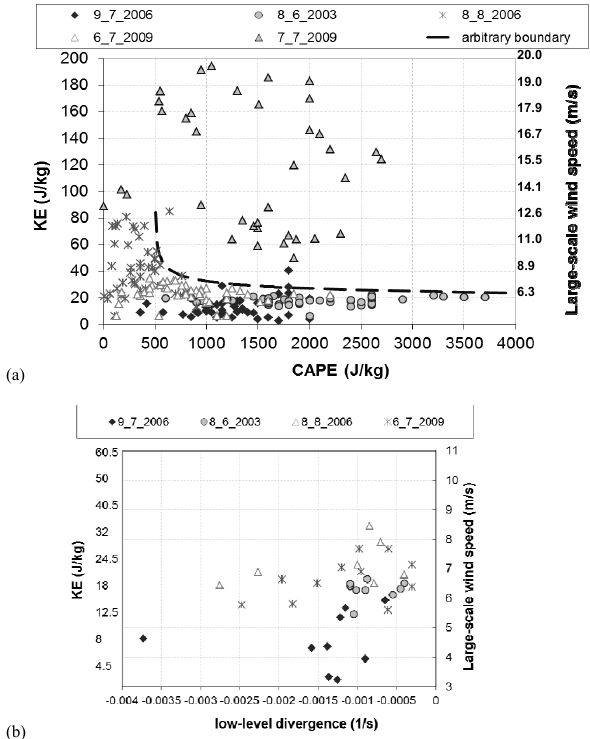
Figure 15. (a) Relationship between maxima kinetic energy (KE) of the large-scale flow and the maxima CAPE, calculated for 1-D profiles in four points (Pazin, S1, S3 and S4 in Fig. 1) in the finest model domain. Each symbol represents relationship for every hour between 09-19 CET for each day of all four cases (C1-C4). The KE maxima are calculated (= V m 2 /2) according to the maxima horizontal wind speed ( V m) in the layer between 850-500 hPa. A bold dashed line displays arbitrary boundary between SB and Cb occurrence and only Cb occurrence. (b) Relationship between V m above Pazin and low-level divergence calculated along B1B2 vertical cross-section. Same as in (a) each symbol represents relationship for every hour between 09-19 CET for each day of all four cases (C1-C4) in the smallest domain.